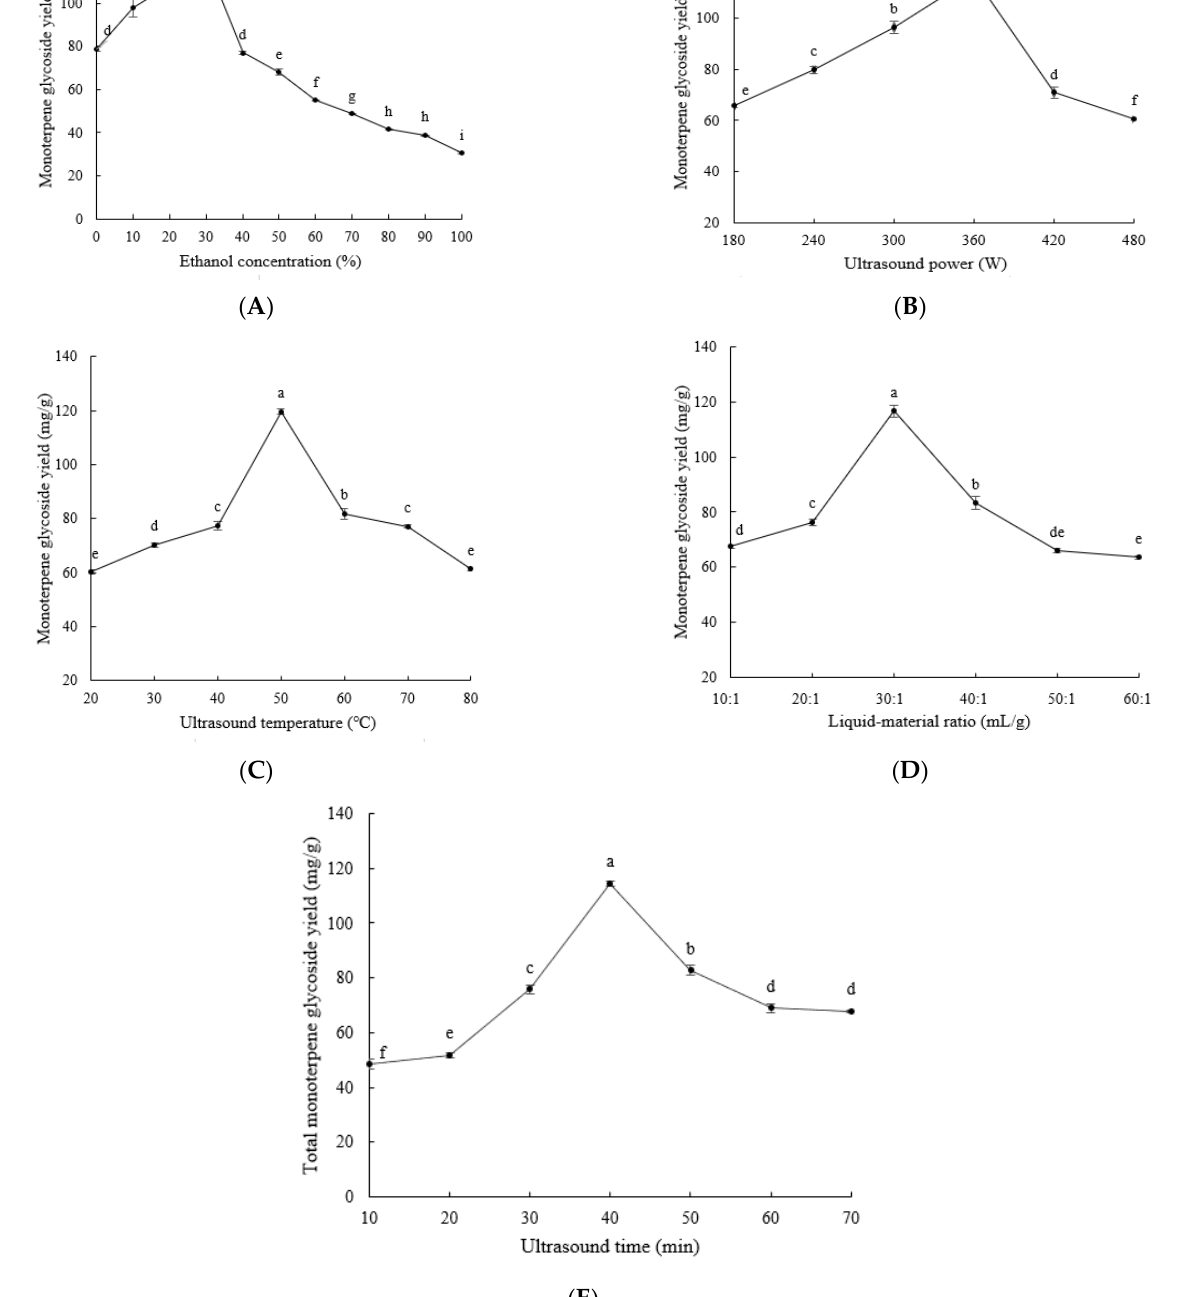
Figure 1. The effects of ethanol concentration ( A ), ultrasound power ( B ), ultrasound temperature ( C ), liquid–material ratio ( D ), and ultrasound time ( E ) on the extraction yield of monoterpene glycosides. Lowercase letters (a–i) indicate significant differences ( p <